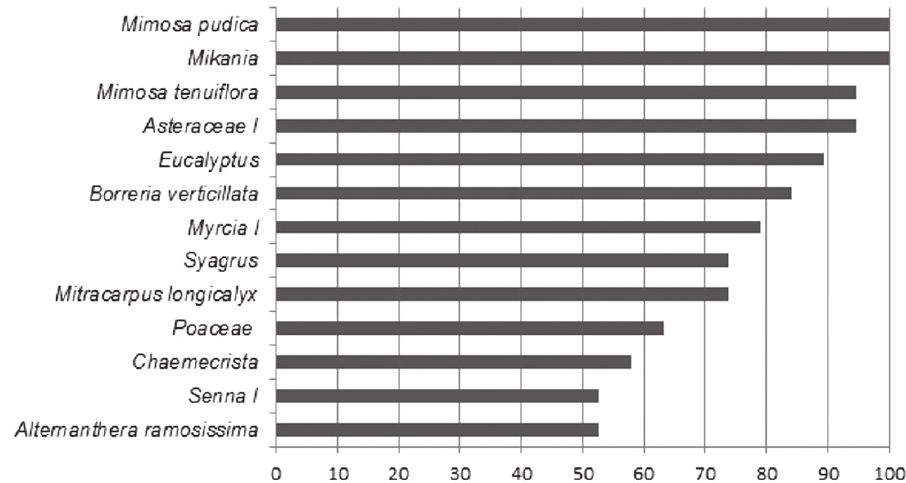
Figure 2 - Pollen types occurring in over 50% of the propolis samples analyzed, produced in the territory of the Agreste of Alagoinhas.